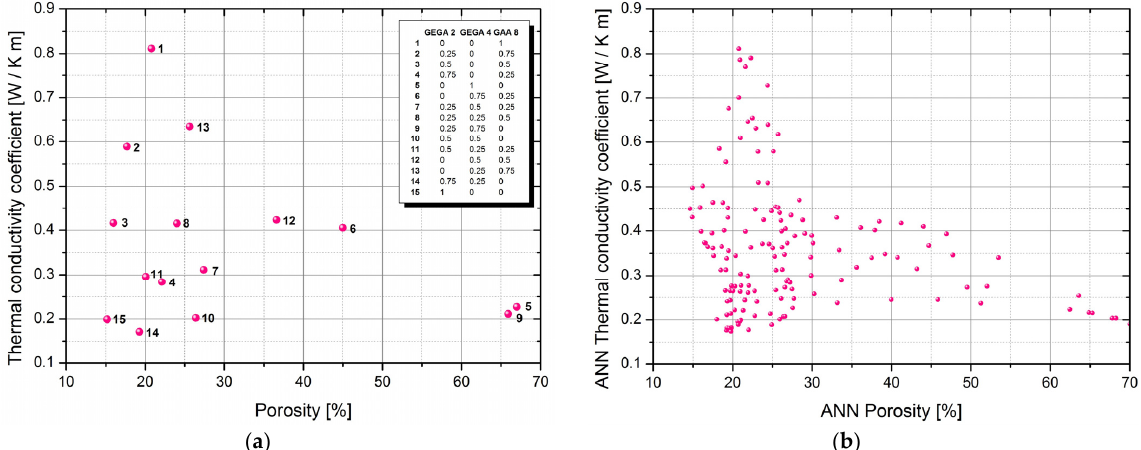
Figure 6. Graphical presentation of the relationship between the thermal conductivity coefficient and porosity of the LWC based on: ( a )the laboratory test results; ( b ) the ANN prediction.